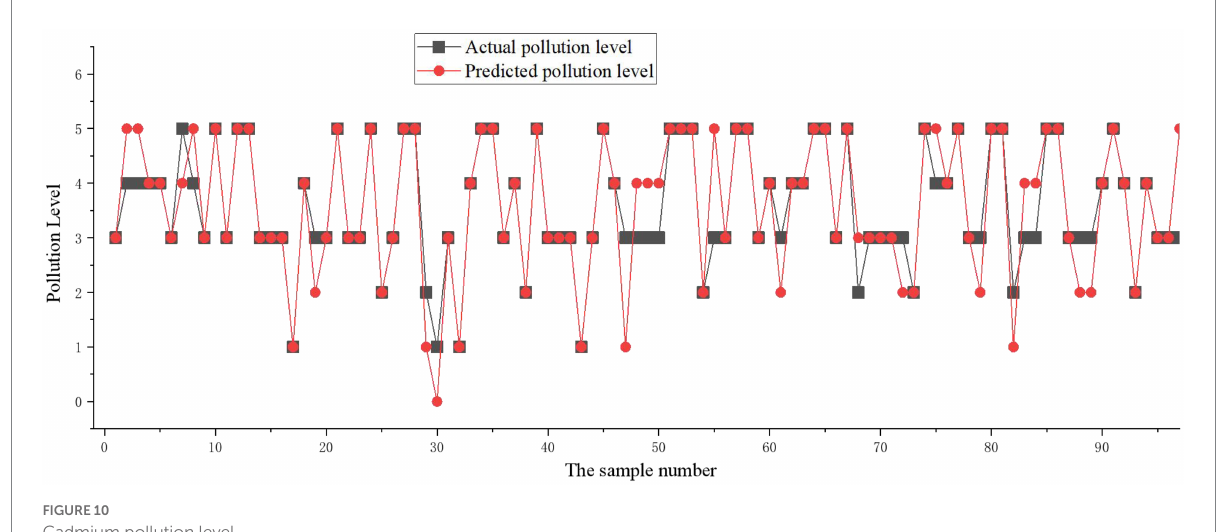
FIGURE 10 Cadmium pollution